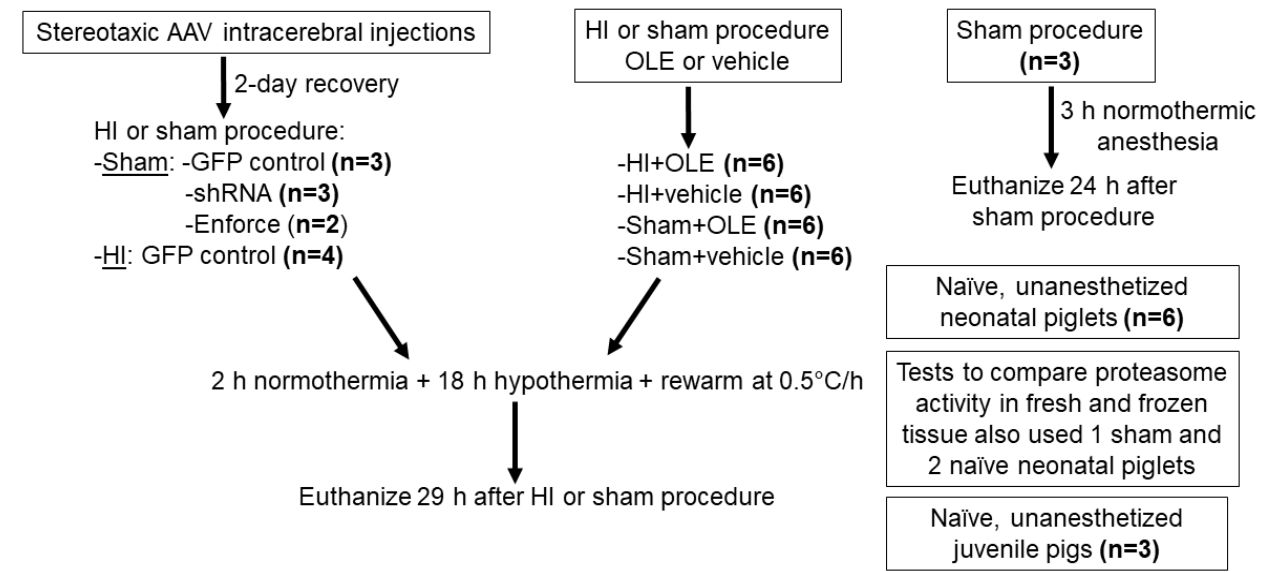
Figure 1. Study design and number of piglets in each experimental group. AAV, adeno-associated virus serotype 9; GFP, green fluorescent protein; HI, hypoxia-ischemia; OLE, oleuropein; shRNA, short hairpin RNA for proteasome subunit gene knockdown; enforce, proteasome subunit gene overexpression. Not included here is a small group of HI piglets recovered with hypothermia (n = 2) or normothermia (n = 2) without OLE or vehicle treatments that were used for pilot proteomic studies.